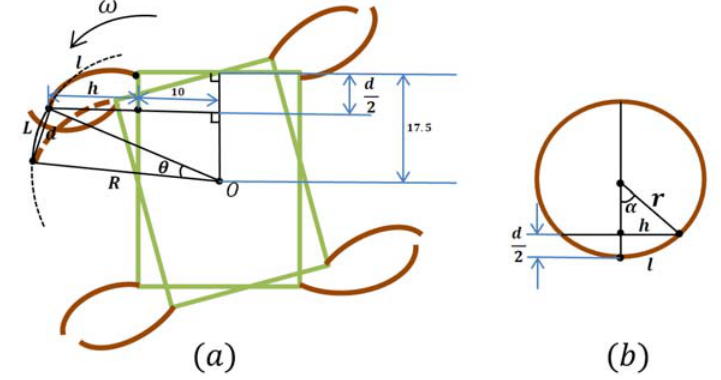
Figure 18. ( a ) The rotating angle in one step cycle. ( b ) The calculation of the value of h . (Only drivers are